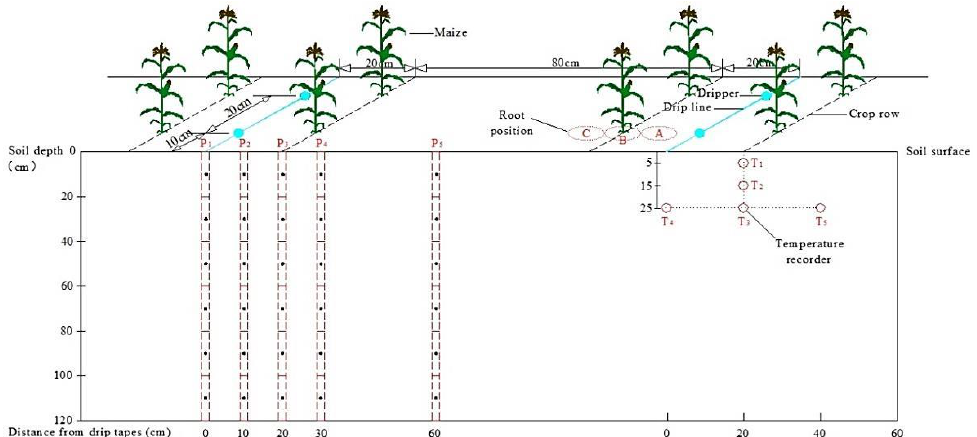
Figure 3. Graphical representation of maize plants and sampling positions in the experimental plots. P1, P2, P3, P4 and P5 are soil sampling locations at distances of 0, 10, 20, 30 and 60 cm from the drip line, respectively. T1, T2, T3, T4 and T5 are soil temperature measurement locations at depths of 5, 15, 25 cm and 0 and 40 cm away from the drip tape, respectively. A, B and C indicate the root sampling locations.